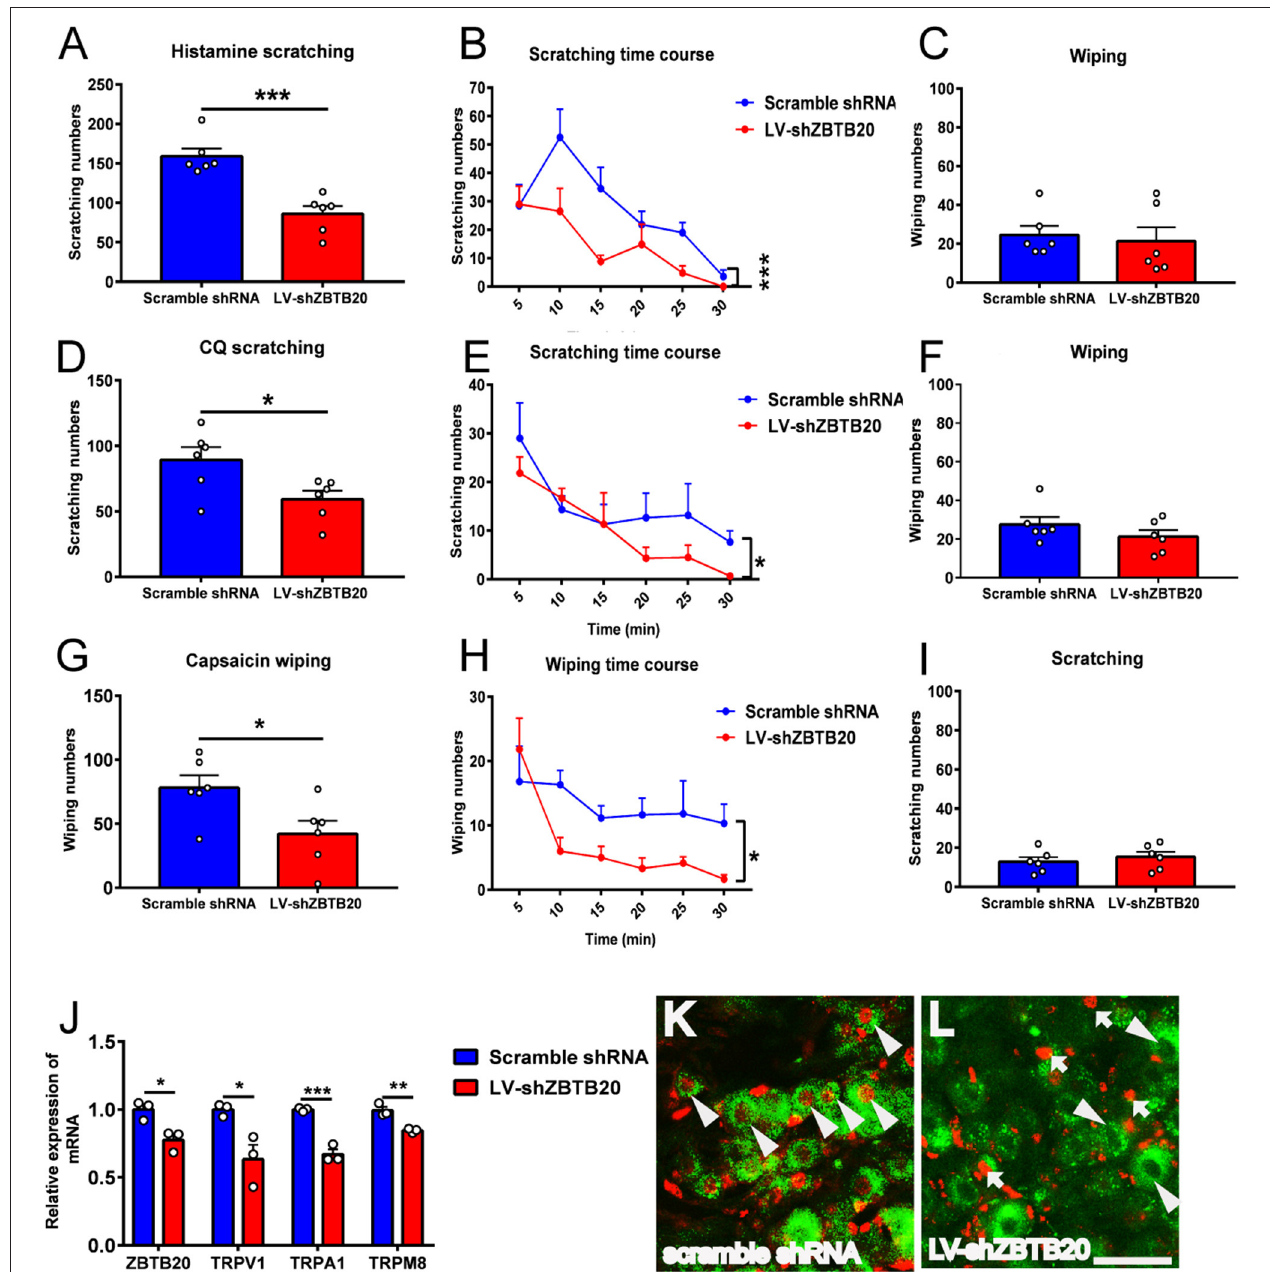
FIGURE 8 | The itch and pain behavior induced by histamine, CQ or capsaicin after silencing endogenous ZBTB20 in the TG. (A) The scratching induced by histamine (50 µ g in 10 µ L PBS) was decreased dramatically in LV-shZBTB20 mice compared to scramble shRNA mice ( t -test, *** p < 0.001). (B) The time course of scratching induced by histamine in LV-shZBTB20 and scramble shRNA mice [F (1, 10) = 29.06; p = 0.0003, *** p < 0.001]. (C) The wiping induced by histamine was maintained at a low level and did not change after histamine injection ( t -test, p > 0.05). (D) The scratching induced by CQ (4 µ g in 10 µ L PBS) was decreased dramatically in LV-shZBTB20 mice compared to scramble shRNA mice ( t -test, * p < 0.05). (E) The time course of scratching induced by CQ LV-shZBTB20 and scramble shRNA mice [ F (1, 15) = 10.27; p = 0.0059, * p < 0.05]. (F) The wiping induced by CQ was maintained at a low level and did not change after CQ treatment ( t -test, p > 0.05). (G) The wiping induced by capsaicin (10 µ g in 10 µ L of solution) was decreased dramatically in LV-shZBTB20 mice compared to scramble shRNA mice ( t -test, * p < 0.05). (H) The time course of wiping induced by capsaicin in LV-shZBTB20 and scramble shRNA mice [ F (1, 10) = 6.548; p = 0.0284, * p < 0.05]. (I) The scratching induced by capsaicin was maintained at a low level and did not change after capsaicin treatment. N = 6 for each group. (J) The mRNA expression of ZBTB20, TRPV1, TRPA1, and TRPM8 in the TG was decreased significantly in LV-shZBTB20 mice compared to scramble shRNA mice ( t -test, * p < 0.05, ** p < 0.01, *** p < 0.001). N = 3 for each group. (K,L) Example showing immunofluorescent staining of ZBTB20 with scramble shRNA and LV-shZBTB20 in TG neurons. The arrowhead indicates colocalization of ZBTB20 (red) with scramble shRNA (green) (K) . The arrow indicates ZBTB20 (red), and the arrowhead indicates LV-shZBTB20 (green) (L) . N = 3; bar = 50 µ